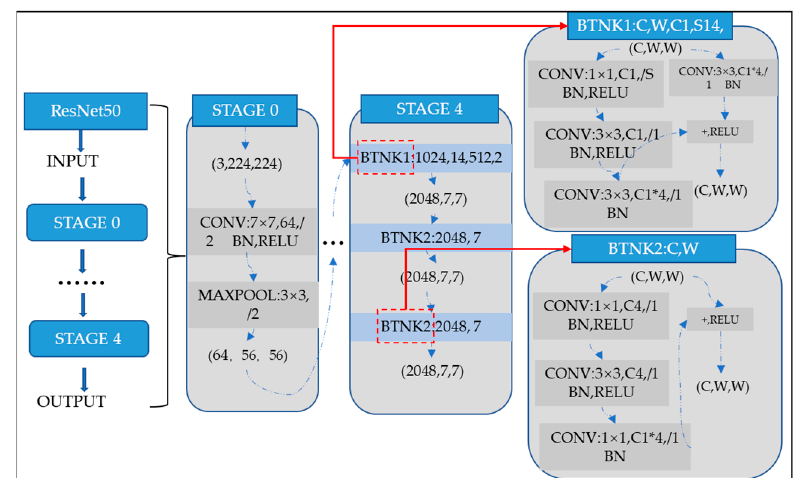
Figure 2. ResNet-50 residual block.